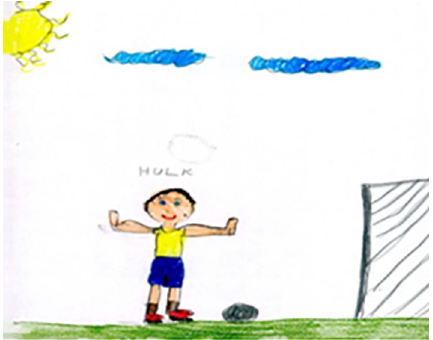
Figure 3. A Brazilian girl's drawings of a player from